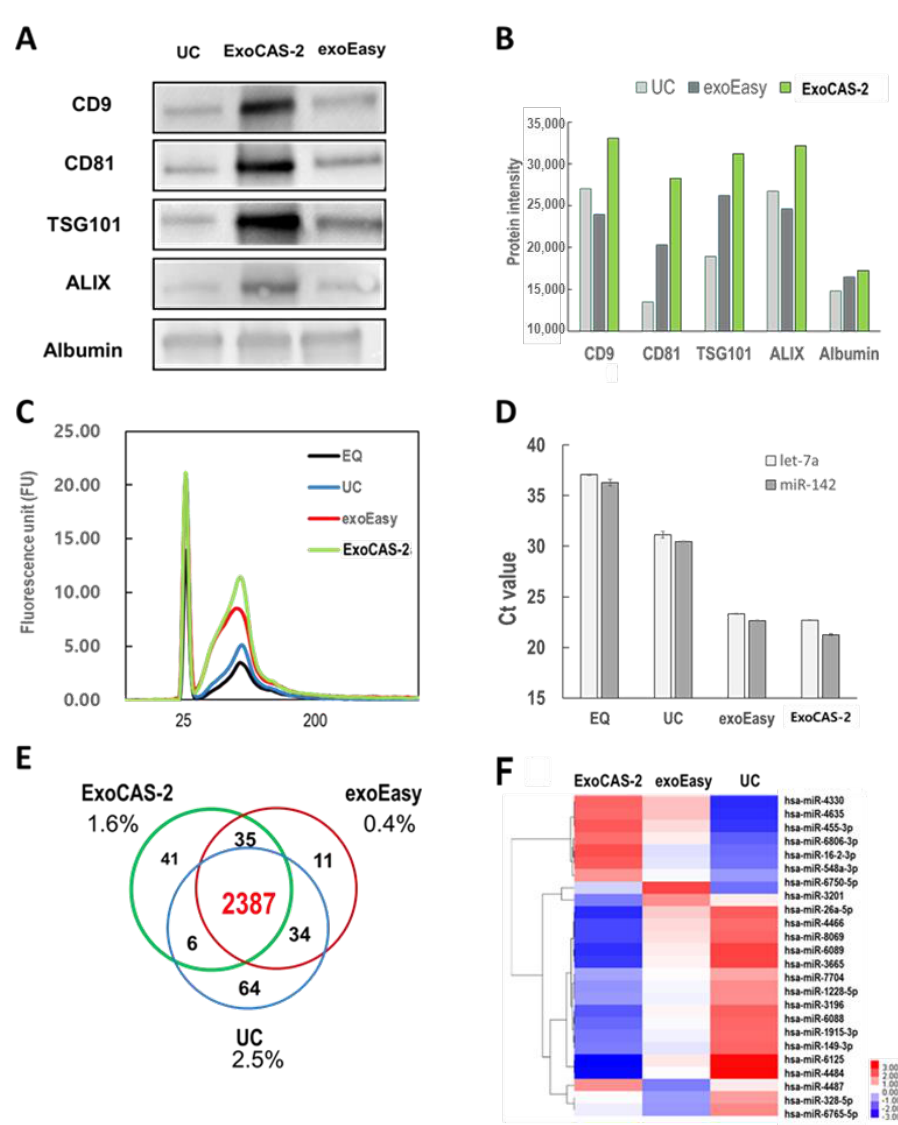
Figure 4. Comparison of EV isolation methods (EQ, UC, exoEasy, PLL beads) using bioanalyzer, western blot, RT-qPCR, and microarray. ( A ) Western blot for investigating protein markers of EVs. ( B ) Western blot analysis for proteins extracted from EVs. ( C ) Analysis of total exosomal RNA using bioanalyzer with Agilent eukaryote total RNA pico chips. ( D ) Exosomal miRNAs (hsa-let-7a-5p, hsa-miR-142-3p) measured by RT-qPCR. ( E , F ) Venn diagram and heatmap depicting gene expression by microarray analysis. EQ: ExoQuick (SBI), UC: ultracentrifugation, exoEasy (Qiagen), ExoCAS-2: present